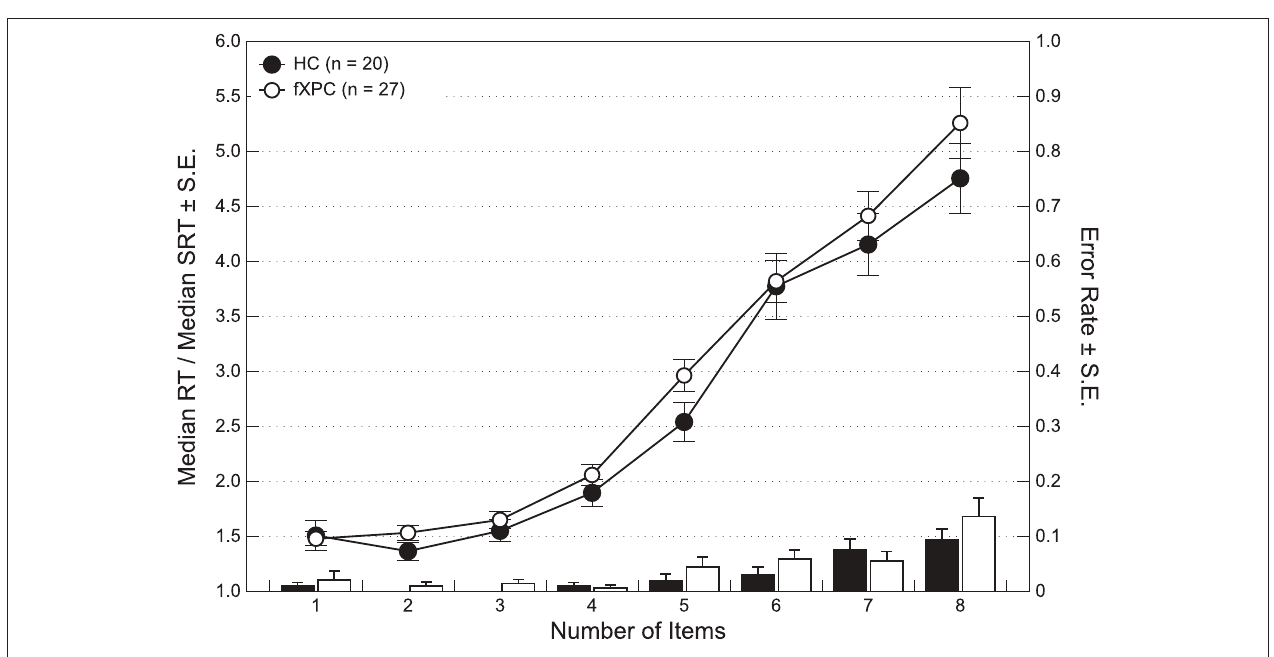
FiguRe 2 | group analyses of response time and controlled for simple reaction time performance show that female fXPCs, as a whole, responded similarly to female HCs, p = 0.27. Normalized response times increased as the number of items to enumerate increased ( p < 0.0001), which did not differ between the two groups, p = 0.12.